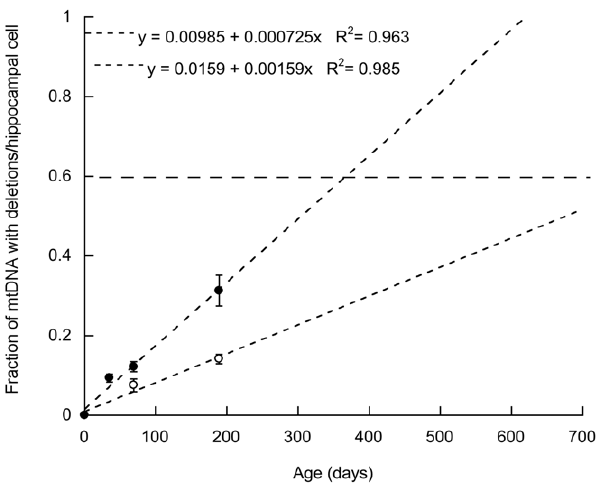
Figure 4. mtDNA deletions in HET-CRE and HET hippocampus accumulate with age. Accumulation of mtDNA with deletions (average of deletions at the segments encoded for CYTB, COX3 and ND4) with age per single hippocampal cell from HET (white circles) and HET-CRE (black circles). The mtDNA deletions (represented as the mean 6 SEM) values were fitted to a linear regression (equations shown in the figure) and the goodness of the regression was expressed as r 2 . From the slope of each equation, the copy-error probability was estimated by using the following formulae N del =(N mtDNA *P del *t * ln 2)/ t 1/2 , where N del is the number of mtDNA with deletions, t is the age of mice in days throughout their lifetime (estimated as 2 years), N mtDNA =1,200 mtDNA copy number/cell (experimentally determined in hippocampus by evaluating the ratio of mitochondrial ND1 gene copy number to the nuclear PK gene copy number), and a mtDNA half-life ( t 1/2 ) of 10 d [121]. For HET mice, a low copy-error probability was obtained (9.5 6 10 2 6 ) associated with a low incidence of accumulation of deletions with age, becoming more significant towards the end of their life. Higher copy-error probabilities, as that calculated with HET- CRE mice (1.9 6 10 2 5 ) lead to a greater accumulation of mtDNA with deletions throughout a simulated mouse life. A biochemical defect on CCO activity is evidenced when the level of a mtDNA deletion exceeds a critical threshold level of 50%–60% [77] (indicated with a dotted line).